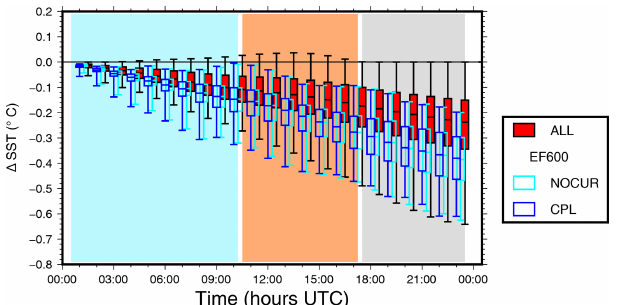
Figure 7. Histogram of the mean rain rate distribution (in number of grid points) for the development (blue) and mature (red) phases in the NOCPL simulation. The enclosed figure zooms in on the highest rates.